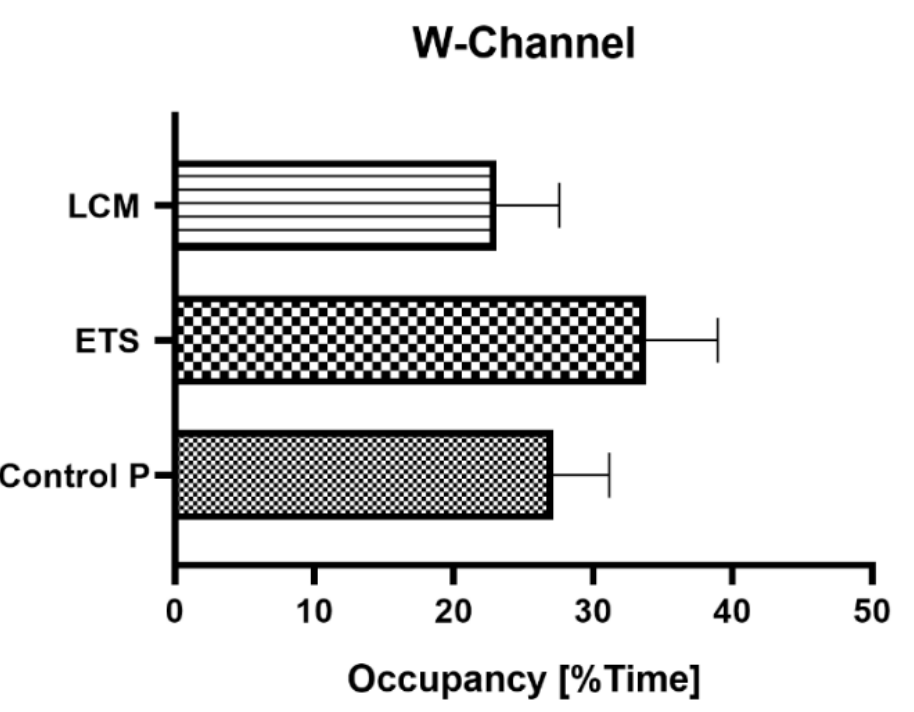
Figure 5. Effect of long-term administration of ETS and LCM on the total average percentage of time spent in the W-Channel.